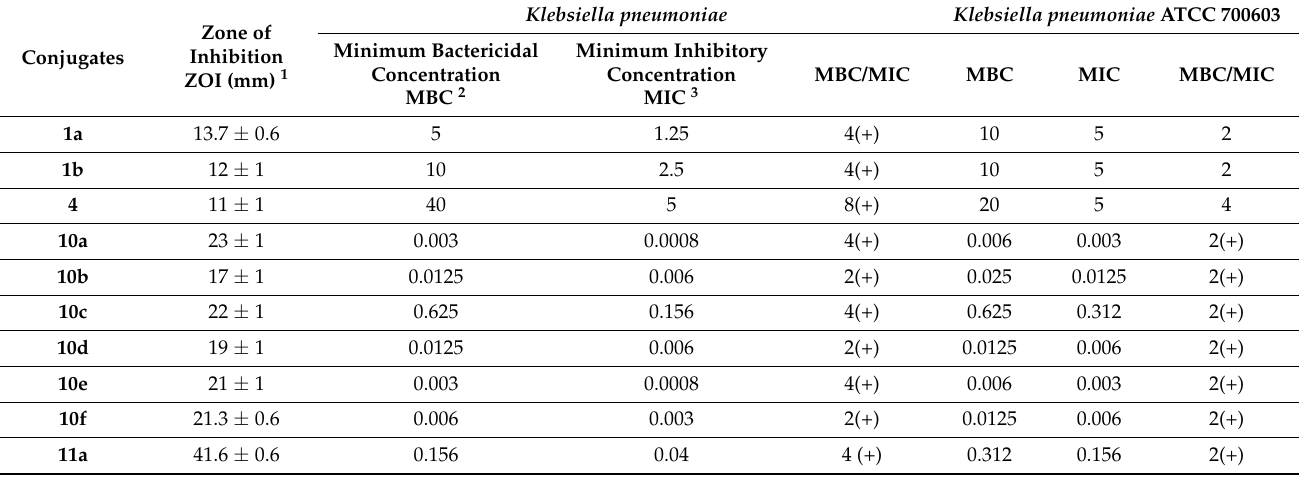
Table 4. Antibacterial activity of conjugates 10a – f and 11a – f against Klebsiella pneumoniae clini- cal